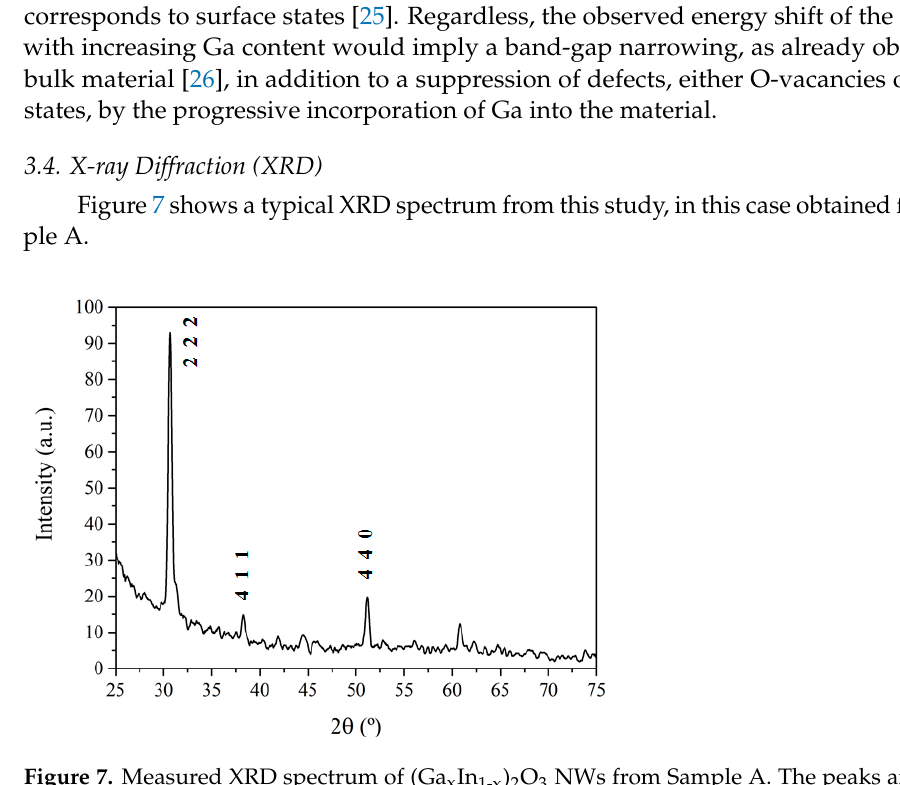
In ) O NWs from Sample A. The peaks are labelled x 1-x 2 3 O known spectrum . 2 3